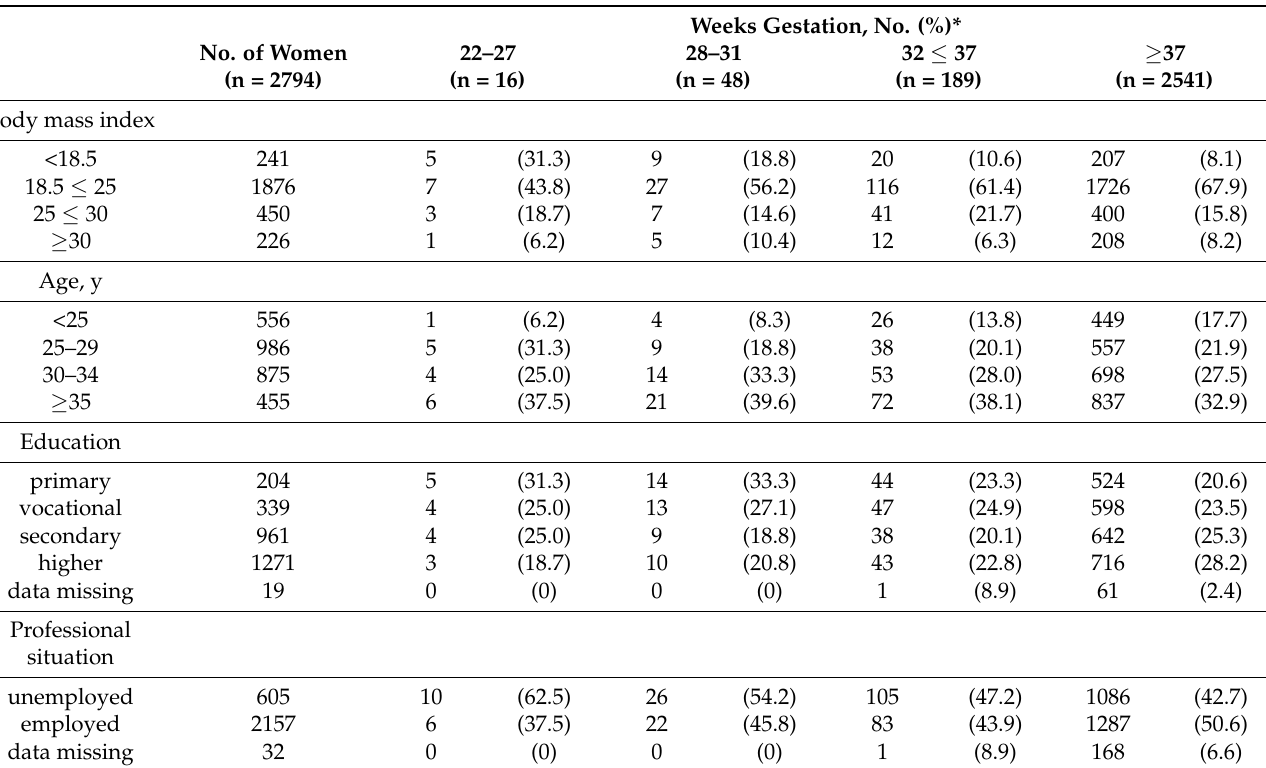
Table 1. Maternal characteristics and rates of preterm